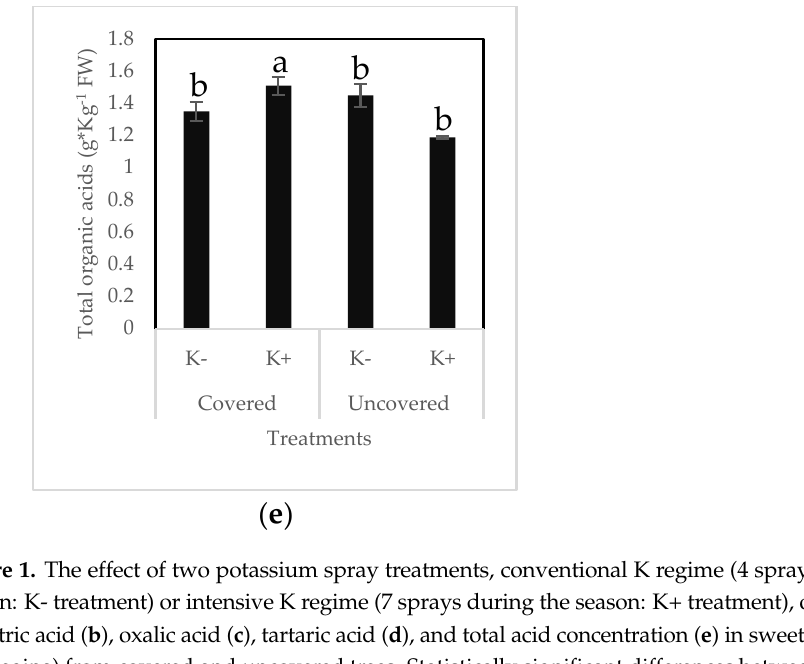
Figure 1. The effect of two potassium spray treatments, conventional K regime (4 sprays during the season: K- treatment) or intensive K regime (7 sprays during the season: K+ treatment), on malic acid ( a ), citric acid ( b ), oxalic acid ( c ), tartaric acid ( d ), and total acid concentration ( e ) in sweet cherry fruits (cv. Regina) from covered and uncovered trees. Statistically significant differences between treatments are represented by different letters above bars, based on the LSD Fisher multiple range test ( p ≤ 0.05). Error bars indicate the standard error for each dataset. Abbreviation: OA (organic acids). Table 7. The effect of two potassium spray treatments, conventional K regime (4 sprays during the season: K- treatment) or intensive K regime (7 sprays during the season: K+ treatment), on the organic acid composition of sweet cherry fruits (cv. Regina). Fruits produced in the lower and upper zone of the canopy were evaluated separately. Statistically significant differences between treatments are represented by different letters above bars, based on the LSD Fisher multiple range test ( p ≤ 0.05). Error bars indicate the standard error for each dataset. Abbreviation: OA (organic acids).